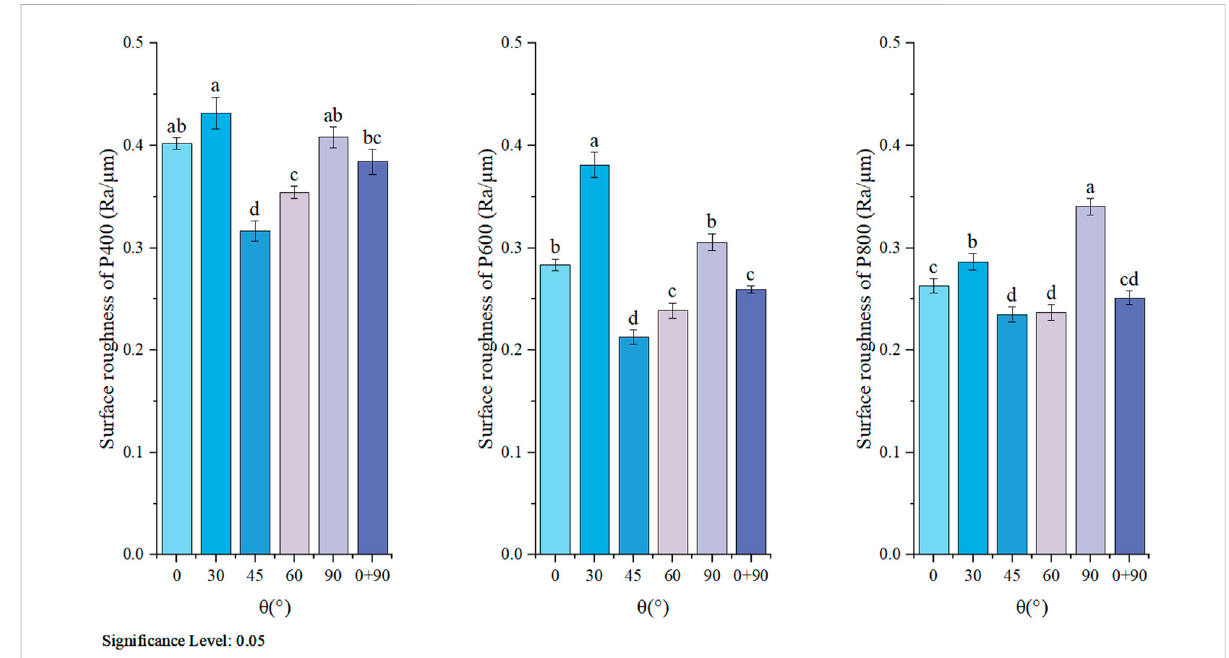
FIGURE 5 Post hoc comparison of surface roughness results.